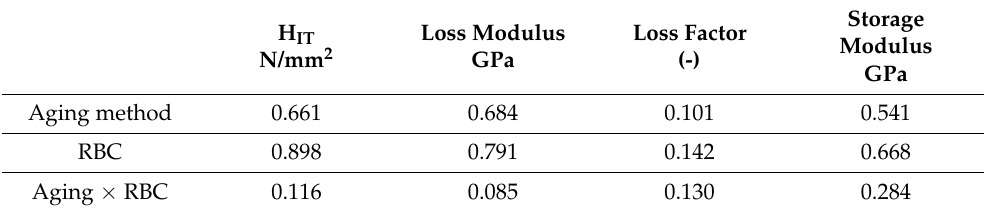
Table 4. Multivariate analysis (general linear model) and the effect strength of the main factors— aging method and RBC—and their combined effect on the parameters tested and a frequency of